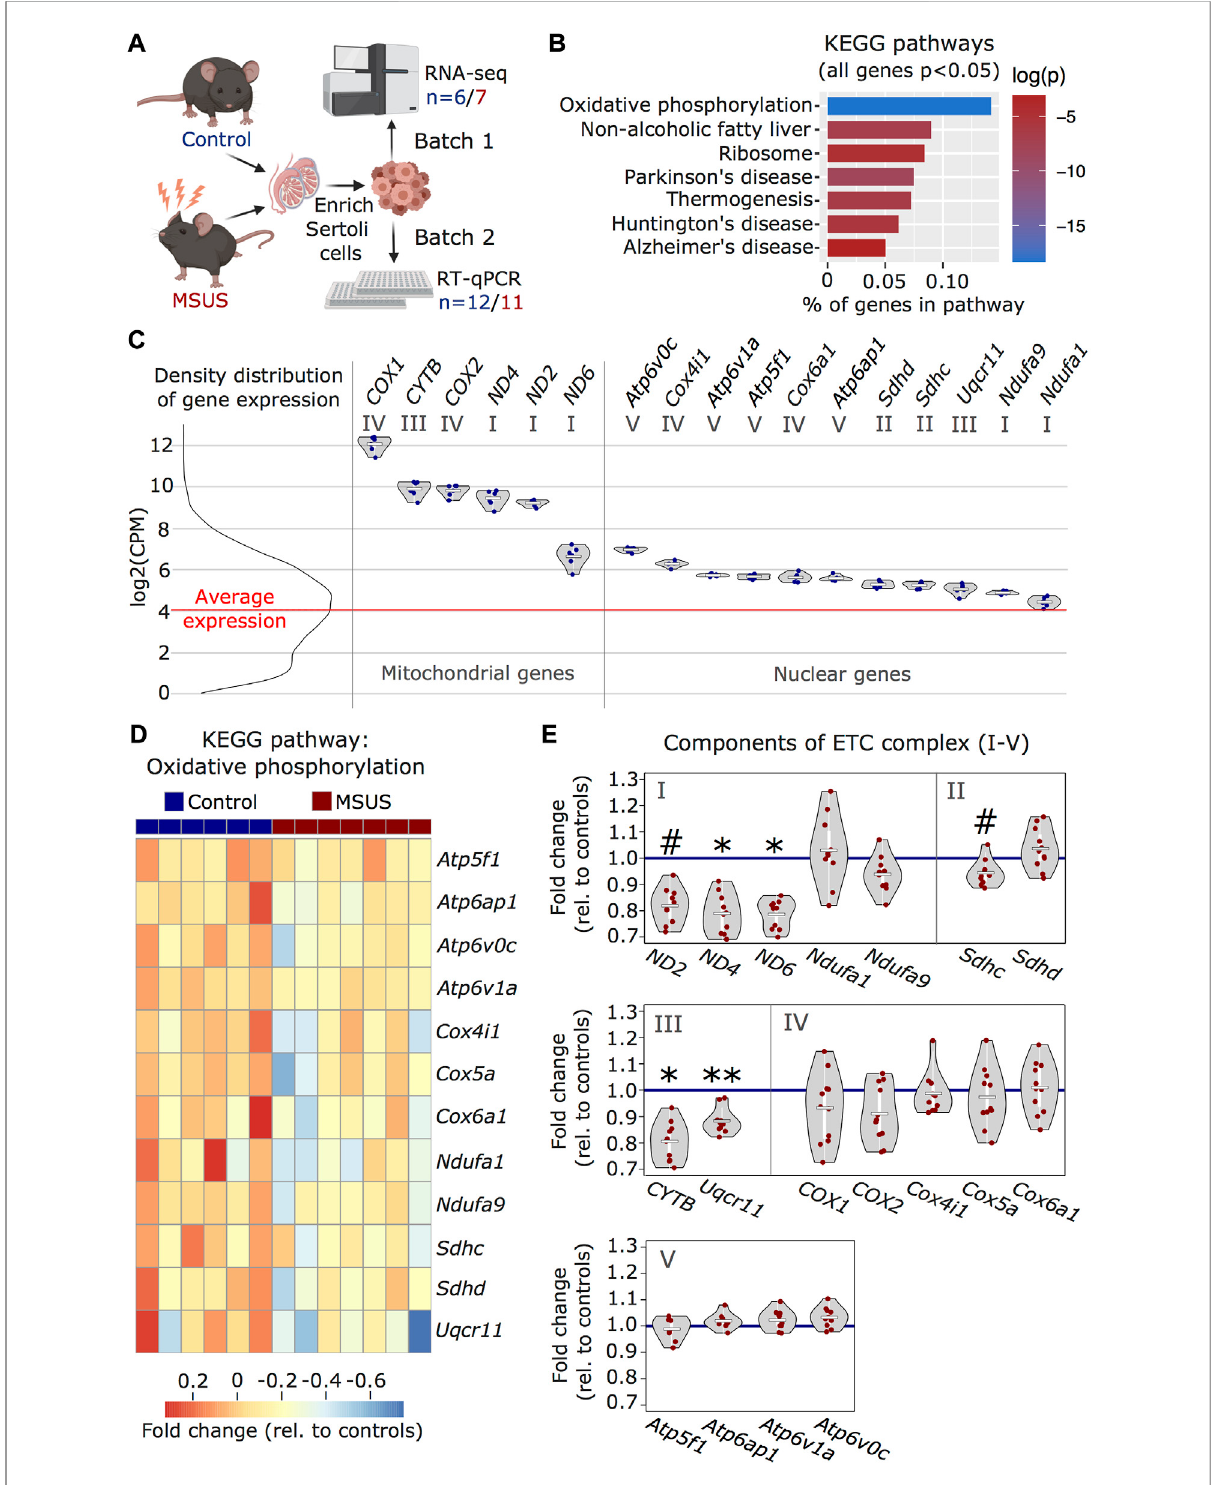
FIGURE 3 Transcriptomic analyses of MSUS and control adult Sertoli cells. (A) Schematic representation of the experimental strategy for Sertoli cells enrichment and transcriptomic analyses for control (blue) and MSUS (red) mice. For RNA sequencing, n = 6 controls and n = 7 MSUS (Batch 1). For validation ofcandidategeneswithRT-qPCR, n =12controlsand n =11MSUS(Batch 2). (B) KEGGpathwaysofsigni fi cantly alteredgenes( p < 0.05)in Sertoli cells from MSUS males with % genes per pathway (x axis) and log of p-value (log( p )) on vertical color scale. (C) Expression pro fi le of